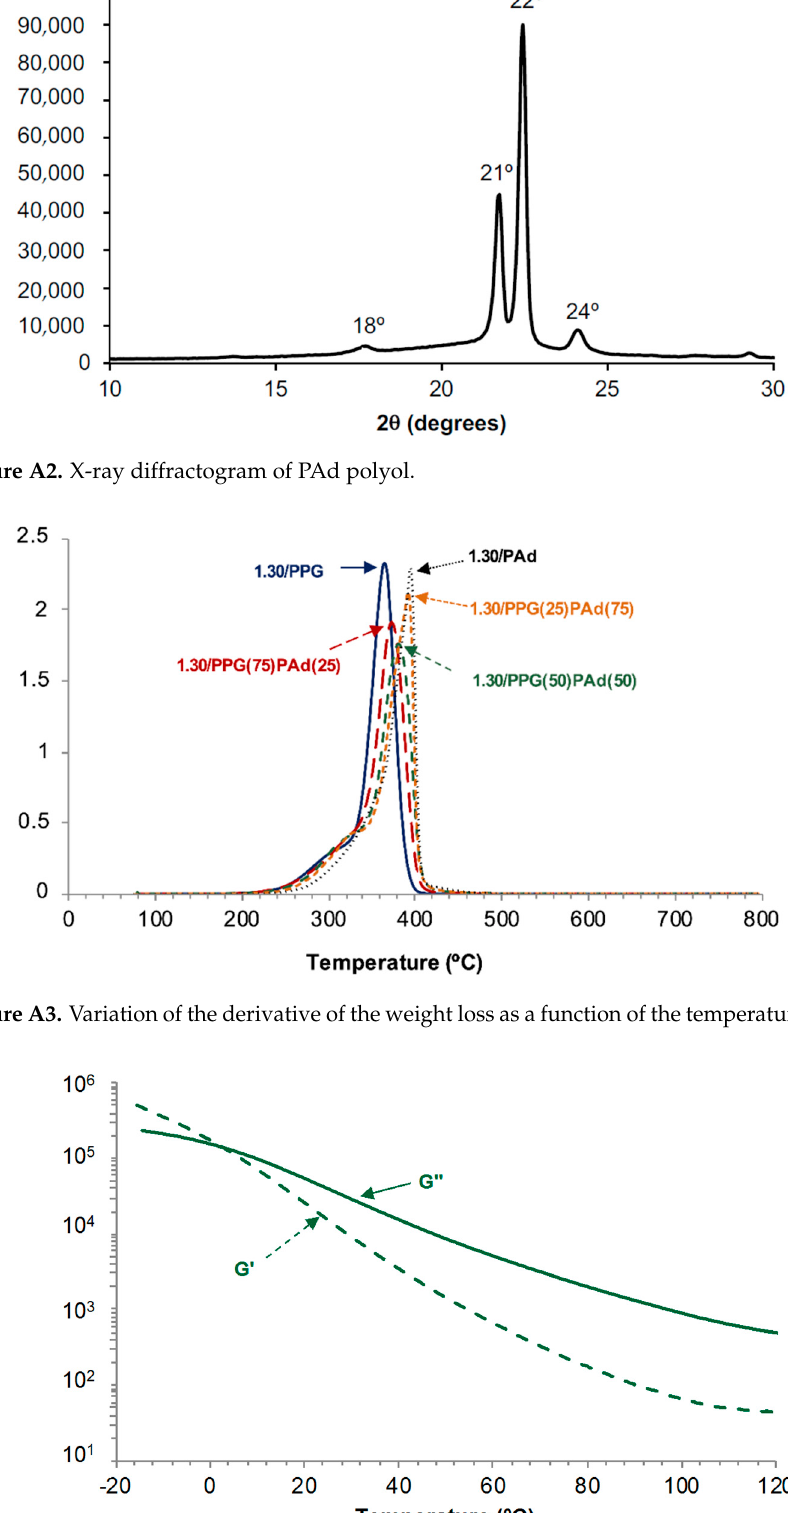
Figure A4. Variation of the storage (G’) and the loss (G’’) moduli as a function of the temperature for 1.30/PPG(50)PAd(50). Temperature sweep plate-plate rheology experiments.